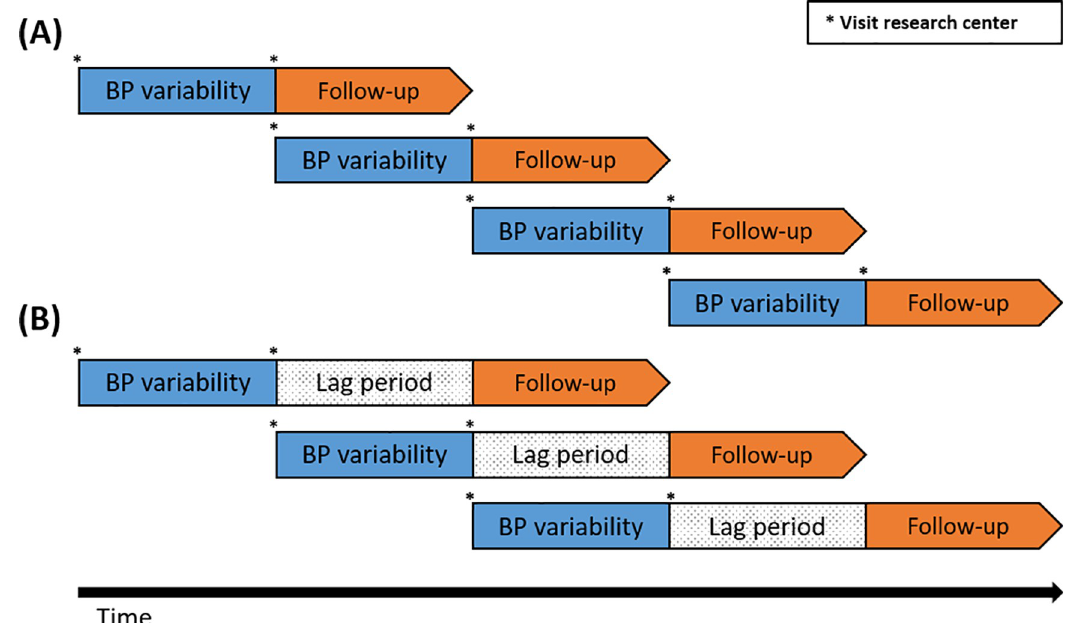
Fig 1. Schematic presentation of the analyses with and without a lag period. (A) Analyses without lag periods, in which blood pressure (BP) variability is measured over 2 visits with immediate follow-up for stroke incidence thereafter. Blood pressure variability is then updated when the participant visits the research center again. (B) Analyses with lag periods. After blood pressure variability measurement, a lag period of 3, 6, or 9 years is incorporated before follow-up for incident stroke to account for reversed